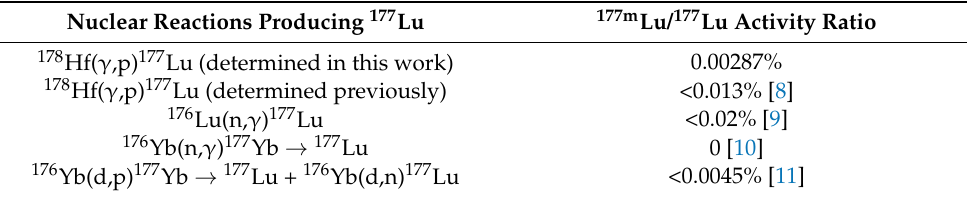
Table 2. 177m Lu/ 177 Lu activity ratios in production of 177 Lu via different methods. Nuclear Reactions Producing 177